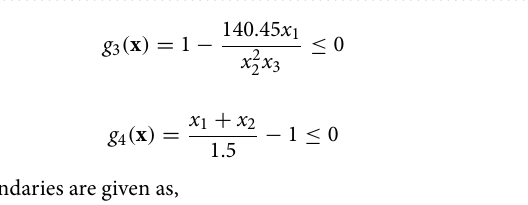
Figure 5. Exploration and exploitation stages through the optimization